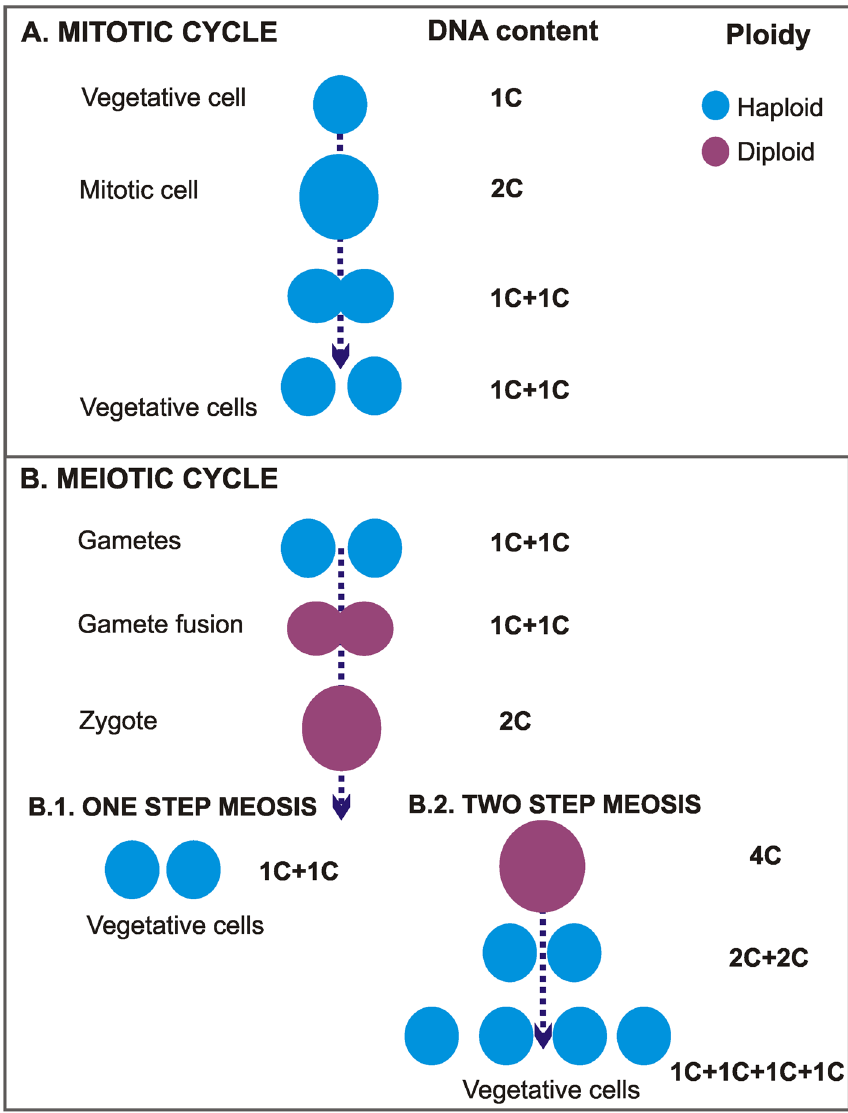
Figure 1. Differences in DNA content and ploidy state between the mitotic and the meiotic cycle, including the two meiotic processes proposed for dinoflagellates (one-step and two-step